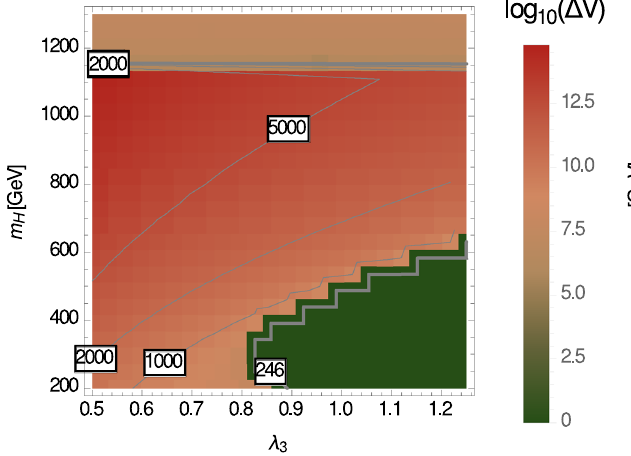
(cid:18) v 2 + 4 (v 2 + v 2 ) . The other parameters are set to λ values for η χ φ λ = − 0 . 1, λ = 0 . 1, α = 20 ◦ , s = 0 . 33 H 4 5